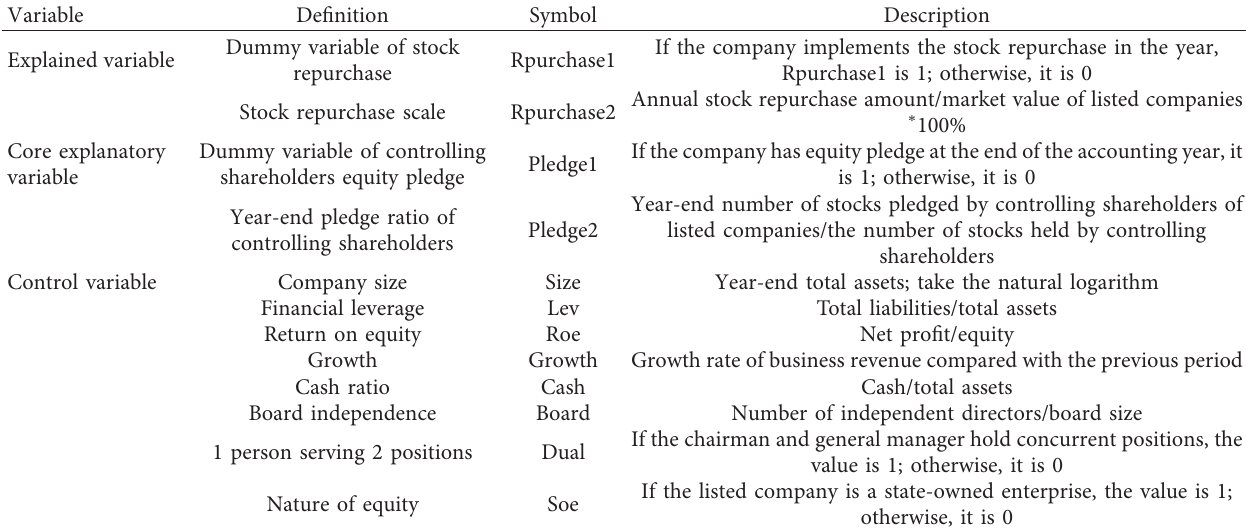
Table 1: Variable description.